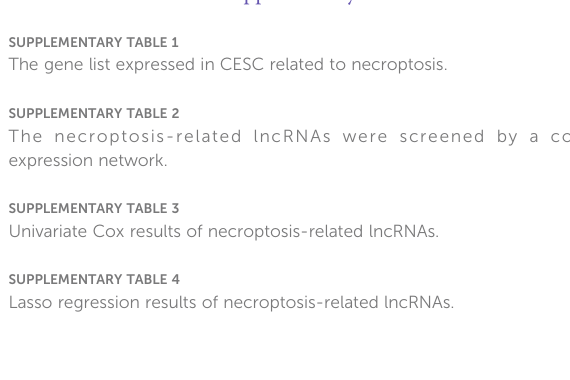
SUPPLEMENTARY TABLE 4 Lasso regression results of necroptosis-related